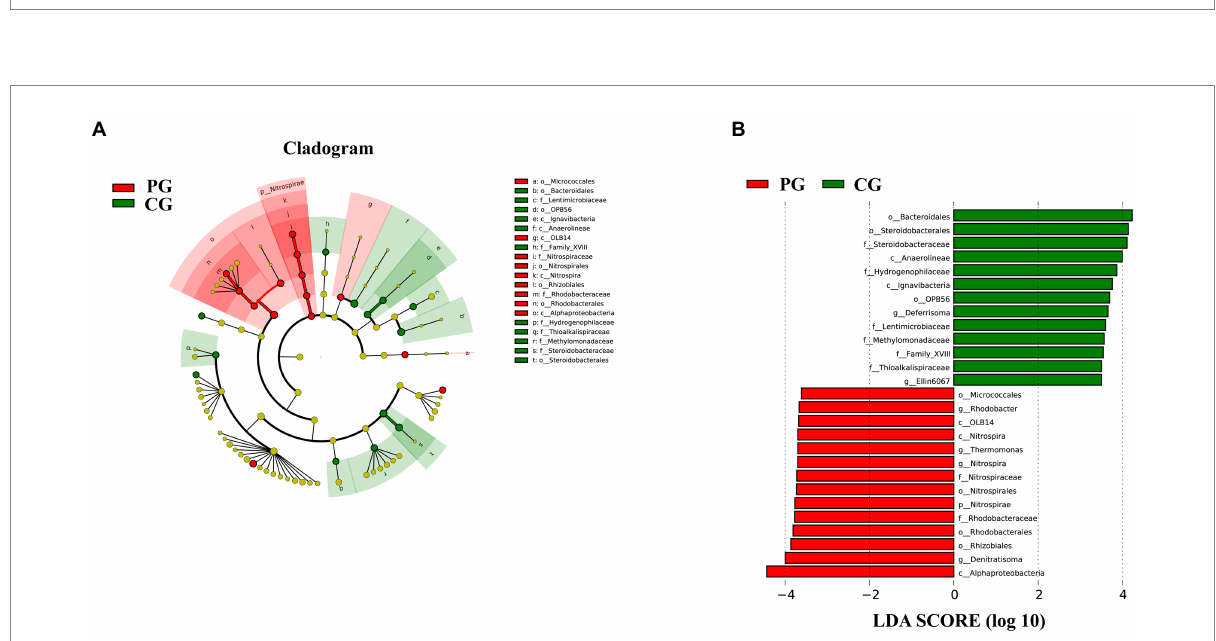
FIGURE 7 Linear discriminant analysis (LDA) effect size (LEfSe) analysis highlights the statistical and biological differences in sediment bacteria between PG and CG groups at the end of the experiment (LDA > 3.5), including the cladogram of the bacterial community (A) and the histogram of LDA scores (B) . Rings from the innermost to the outermost in the cladogram stand for the domain, phylum, class, order, family, and genus, respectively. The diameter of each circle in the cladogram reflects the abundance of that taxon in the community. Significant (red and green) and non-significant (yellow) discriminant taxonomic nodes are